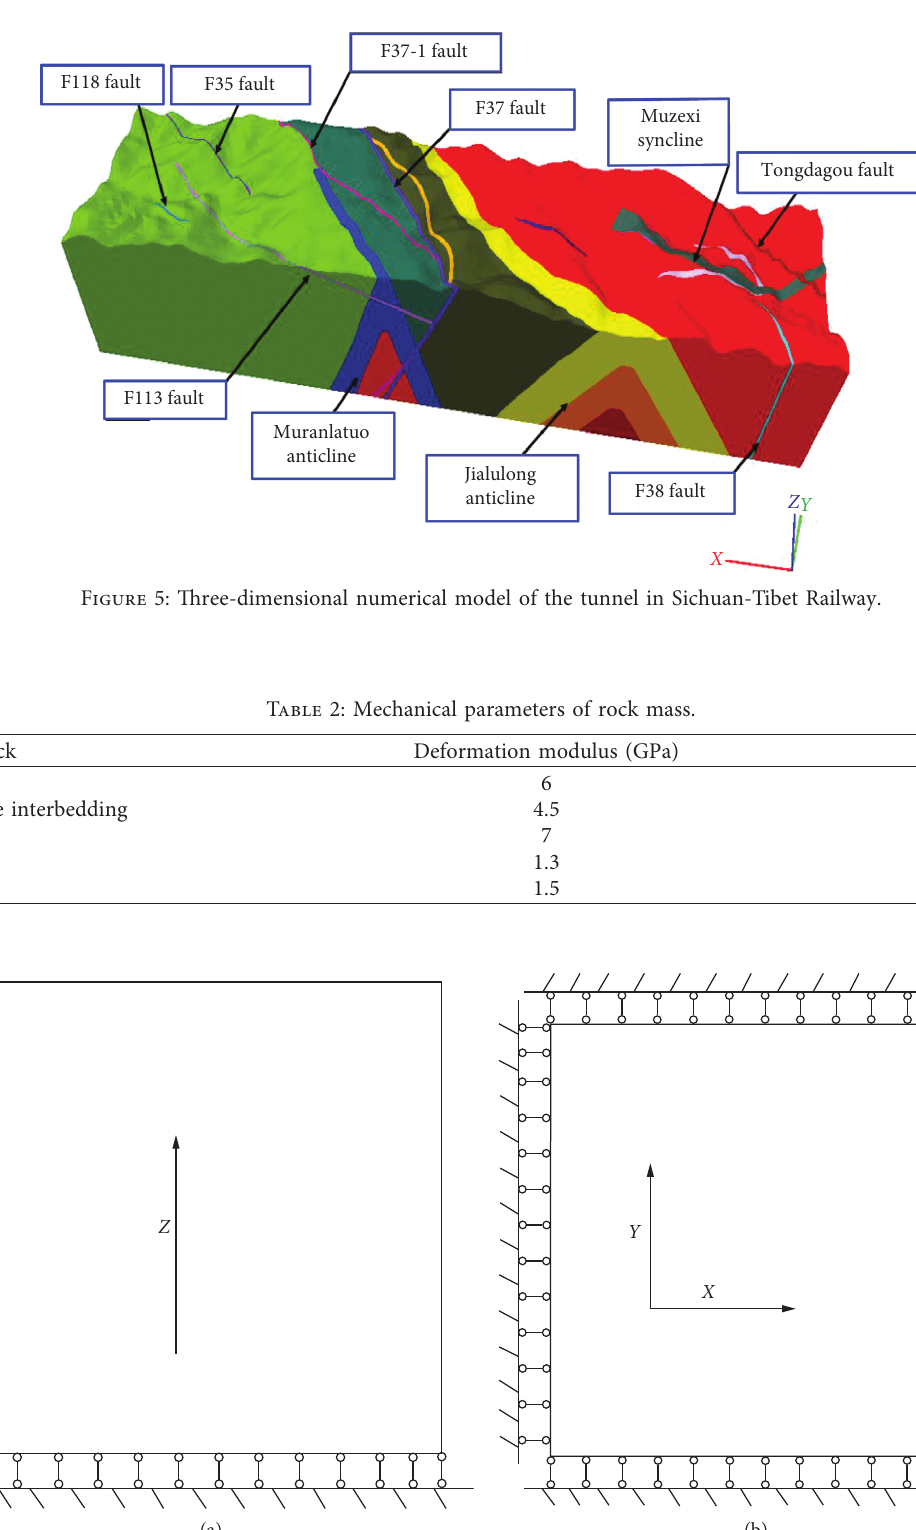
Figure 6: Displacement boundary conditions of global model. (a) Vertical displacement boundary conditions. (b) Horizontal displacement boundary